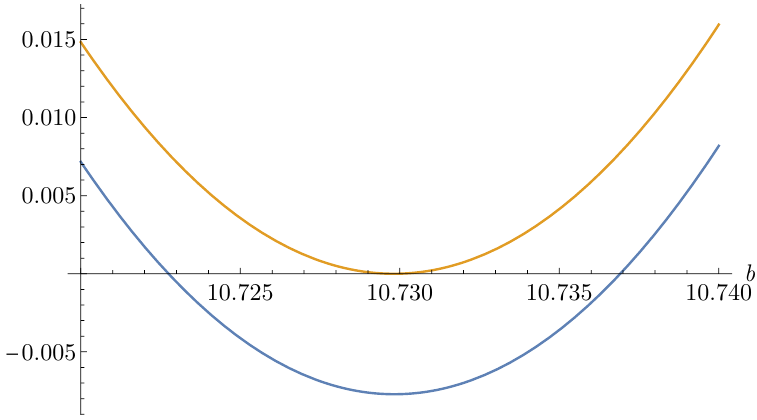
Figure 8 . A functional returned by SDPB before refinement (blue) and after 3 steps of refining the discretization and re-running SDPB (orange). We plot the action of the functional in impact parameter space, zoomed in near a negative region after the initial run of SDPB . Our initial dis- cretization used step size δ b = 1 / 32 . The functional indeed has a negative region of roughly size δ b , with minimum value − 0 . 0077 in this region. After the refinement steps, the negative region is b ∈ (10 . 7298112 , 10 . 7298134) , and the minimum value of the functional is − 1 . 83 × 10 − 10